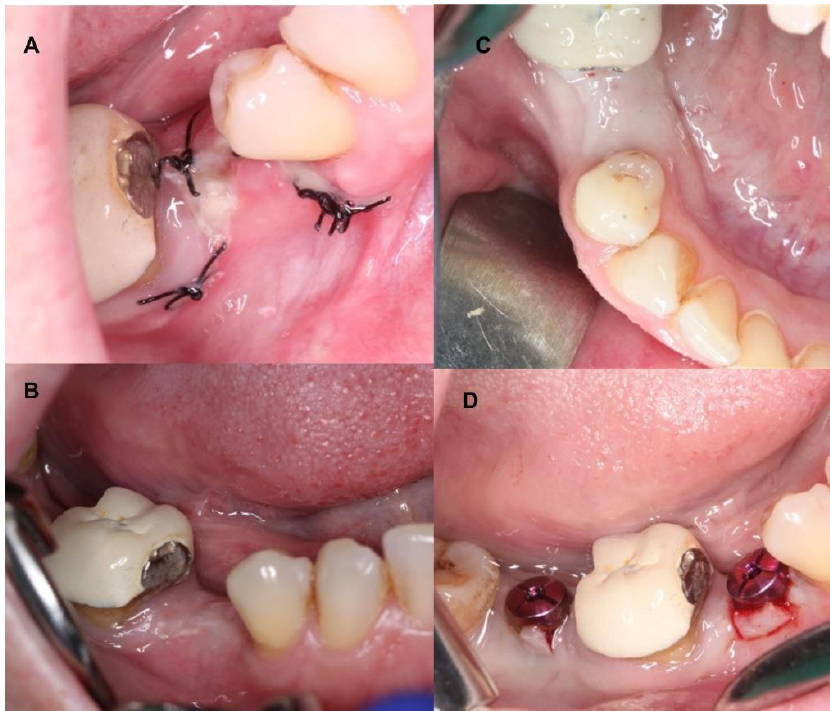
Figure 4. ( A ) Follow-up and removal of the suture after 7 days; ( B ) 1 month follow-up; ( C ) 2 months follow-up; ( D ) 3 months follow- up and healing abutments’ placement.